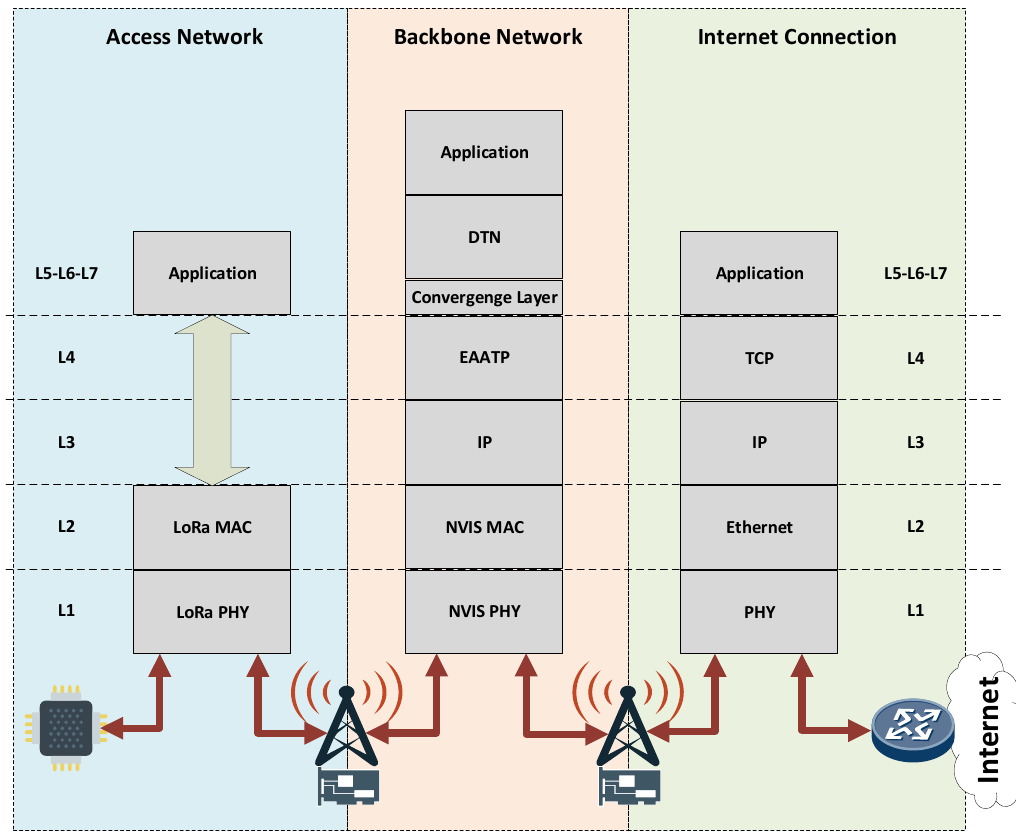
Figure 4. Network architecture of the remote WSN providing the IoT telemetry service.